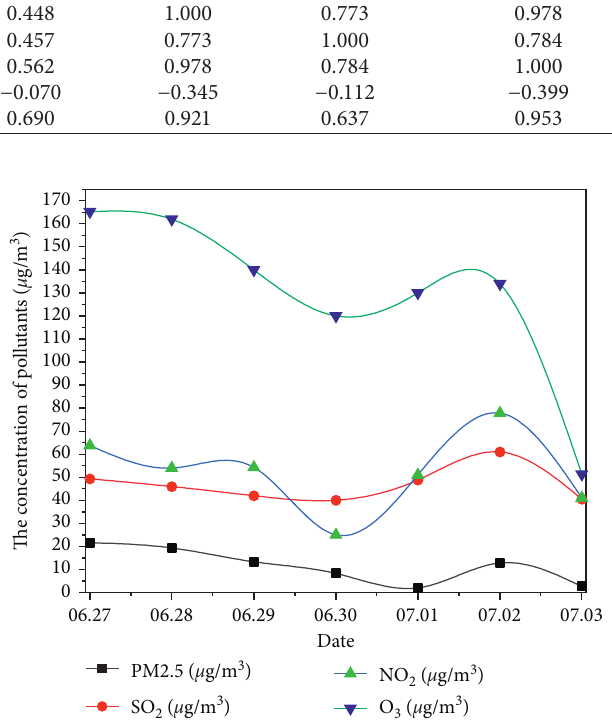
Figure 7: The amount of pollution after construction.